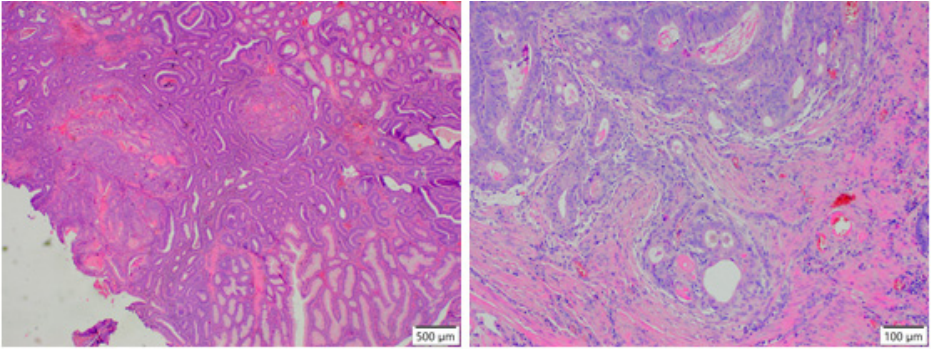
Figure 5. Representative histopathological appearance of adenocarcinoma in the colon. About 20% of CRC is associated with hereditary syndromes such as familial adeno- matous polyposis (FAP), Lynch syndrome (HNPCC), mutation-related polyposis MUTYH (MAP) and hamartomatous polyposis syndromes (Peutz-Jeghers, juvenile polyposis and Cowden disease) [51,77,78]. In the case of HNPCC, one allele of the DNA repair